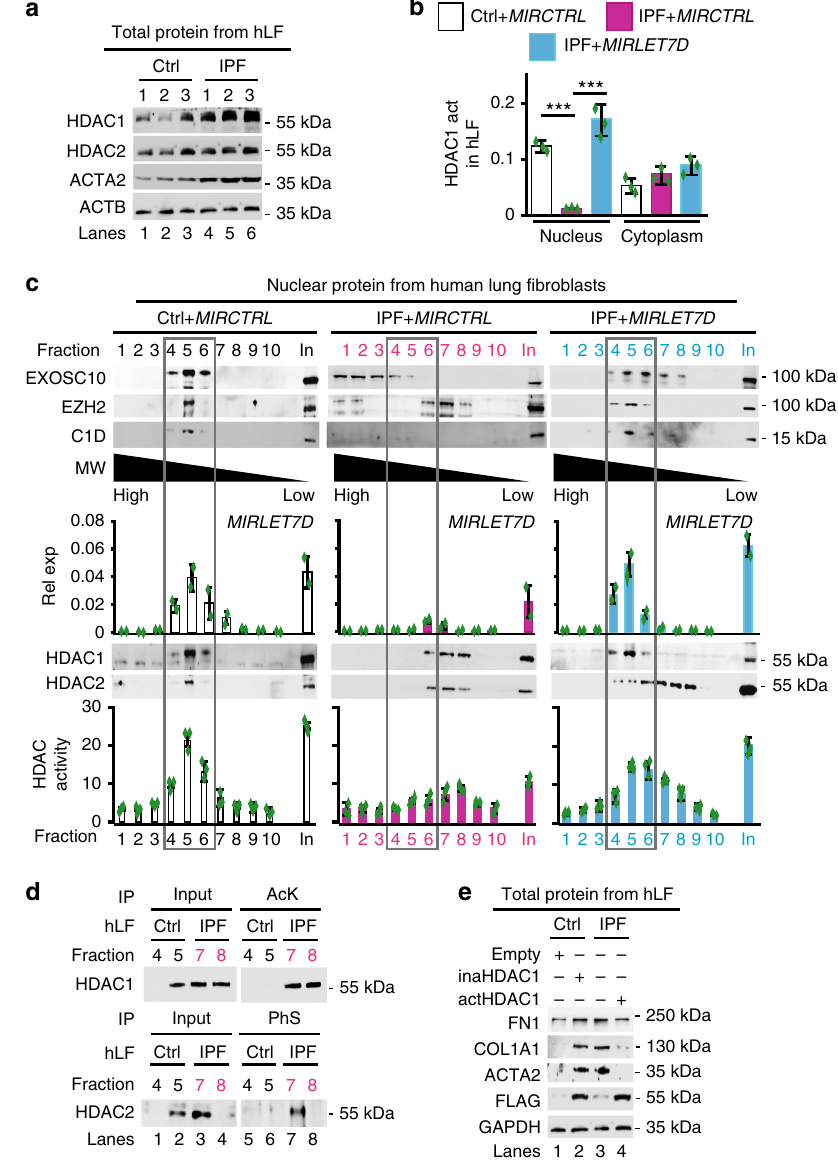
Fig. 5 Nuclear histone deacetylase activity is reduced in IPF. a Western blot (WB) using the indicated antibodies and whole-cell protein extracts from Ctrl and IPF primary human lung fi broblasts (hLF) derived from three different donors, each. b HDAC1-speci fi c activity assay using nuclear or cytosolic protein extracts from Ctrl or IPF hLF that were transfected with control miRNA ( MIRCTRL ) or MIRLET7D probes. c WB using antibodies speci fi c for MiCEE components (top) or HDAC1, or 2 (middle), MIRLET7D -speci fi c TaqMan assay (middle), and fl uorometric HDAC activity assay (bottom) of fractions after sucrose gradient ultracentrifugation (SGU) of nuclear extracts from Ctrl and IPF hLF transfected as in b . Squares show fractions where MiCEE is expected. In, Input (5% of material prior SGU); MW, molecular weight; Rel exp, relative expression. d WB using HDAC1 (top) or HDAC2 (bottom)-speci fi c antibodies after immunoprecipitation using either pan-acetyl-lysine (AcK) or phospho-serine (PhS)-speci fi c antibodies to precipitate endogenous inactive HDAC1 and HDAC2 from selected SGU fractions analyzed in c . Input, 5% of IP starting material. e WB using the indicated antibodies and whole-cell protein extracts from Ctrl and IPF hLF that were transfected with an empty plasmid or expression constructs containing inactive (ina) or active (act) HDAC1 as indicated. In all bar plots, data are shown as mean (SD) ( n = 3 biologically independent experiments for a and c ; n = 2 biologically independent experiments for b ). Asterisks in all plots, P -values after unpaired t -test, two tailed, *** P < 0.001; ** P < 0.01; * P < 0.05; ns, not signi fi cant. Source data are provided as a Source Data fi le. See Supplementary Fig. EZH2, demonstrating the interaction with functional components of the MiCEE complex. To further investigate these interactions, we analyzed by Co-IP assay nuclear protein extracts from Ctrl fi broblasts that were transfected either with EXOSC10 full-length ( fl ) or a deletion mutant lacking the amino acids 1 – 285 (del3), thereby losing the ability to interact with C1D 25 (Fig. 6e).